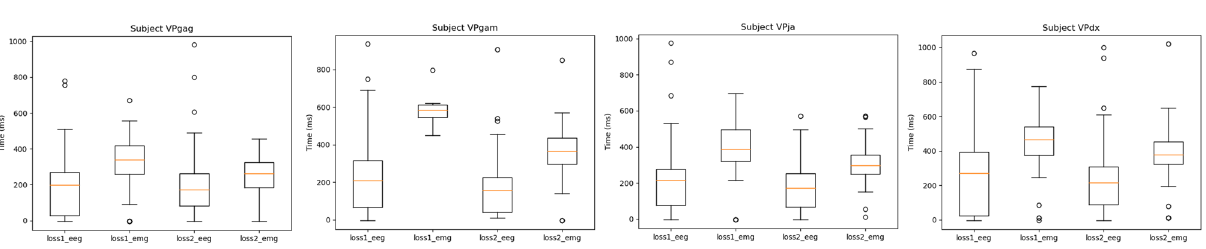
Figure 6. Box plots of reaction time based on both losses from EEG and